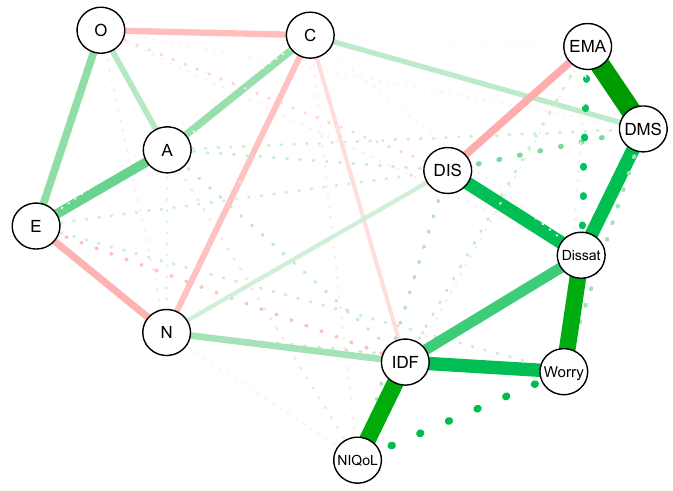
Figure 3. Concentration network of personality traits and Insomnia Severity Index (ISI) items. Green lines indicate positive partial correlations; red lines indicate negative partial correlations. Solid lines indicate shortest paths, the other partial correlations are shown as dashed lines. The color saturation, thickness and length of the edges represent the strength of the association. Abbreviations: DIS = Difficulty Initiating Sleep, Dissat = Dissatisfaction with sleep, DMS = Difficulty Maintaining Sleep, EMA = Early Morning Awakening, IDF = Interference with Daily Functioning, NIQoL = Noticeability of Impaired Quality of Life, Worry = Worry about sleep, A = Agreeableness, C = Conscientiousness, E = Extraversion, N = Neuroticism, O = Openness. The graph shows two main clusters of related variables, corresponding to a personality cluster and an insomnia cluster. The insomnia cluster can be further divided into a cluster of daytime symptoms (NIQoL, IDF, and Worry) and a cluster of nocturnal symptoms (DIS, DMS, EMA) that are connected via Dissat. The shortest paths that connect the personality and insomnia cluster contain neuroticism, conscientiousness, IDF, DMS, and DIS.